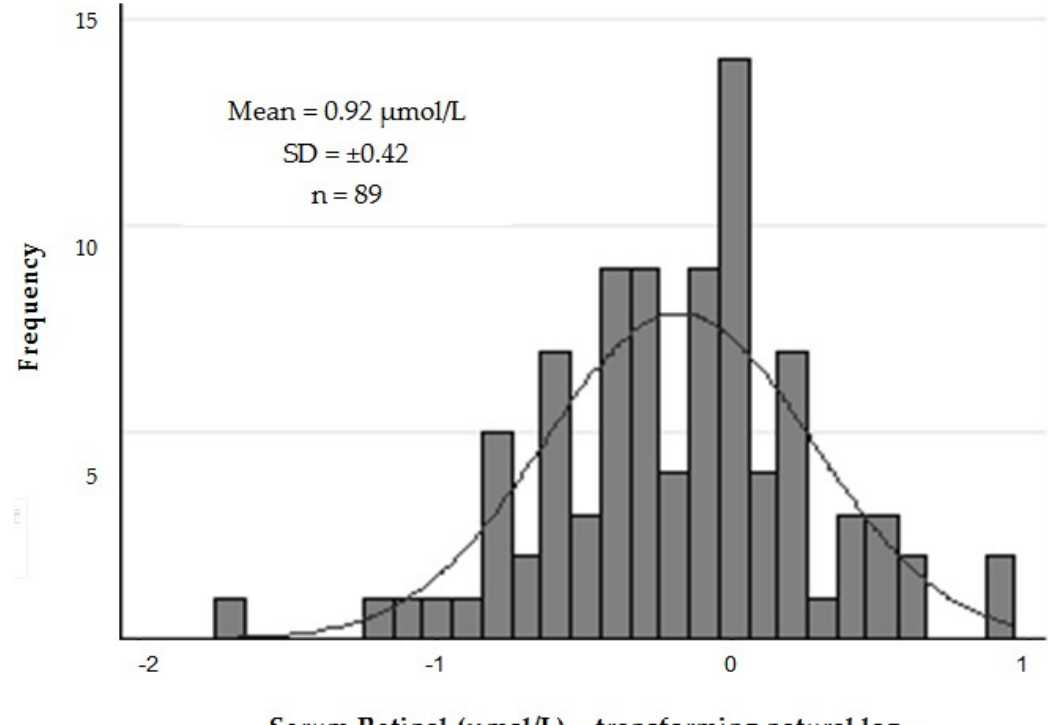
Figure 1. Distribution of serum retinol levels in pregnant adolescents.